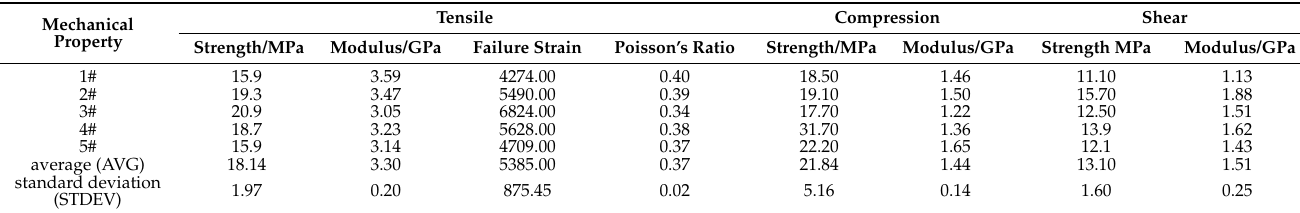
Table 3. Performance parameters of the cured 105-60RT unsaturated polyester resin.